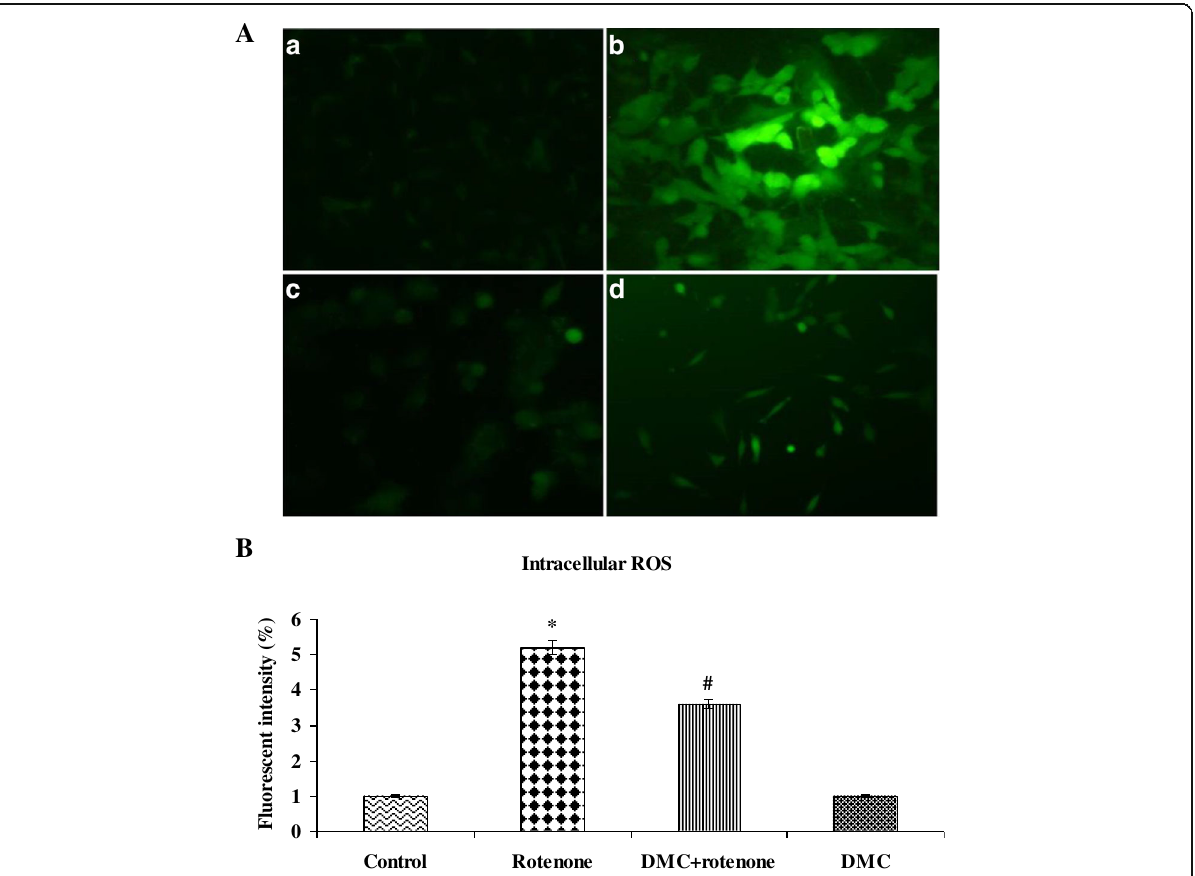
Fig. 4 a DMC reduced ROS formation as stained by 1 μ M CM-H2 DCFDA. a Photomicrograph showing the preventive effect of DMC (50 nM) against rotenone induced ROS generation. a Control, b rotenone, c DMC + rotenone and d DMC. b ROS levels were significantly increased in rotenone (100 nM) treated cells as compared to control cells, while DMC (50 nM) pretreatment significantly decreased the levels of ROS as compared to rotenone alone treated cells. Values are given as mean ± SEM of four independent experiments in each group. * p <0.05 compared to control and # p <0.05 compared to rotenone group